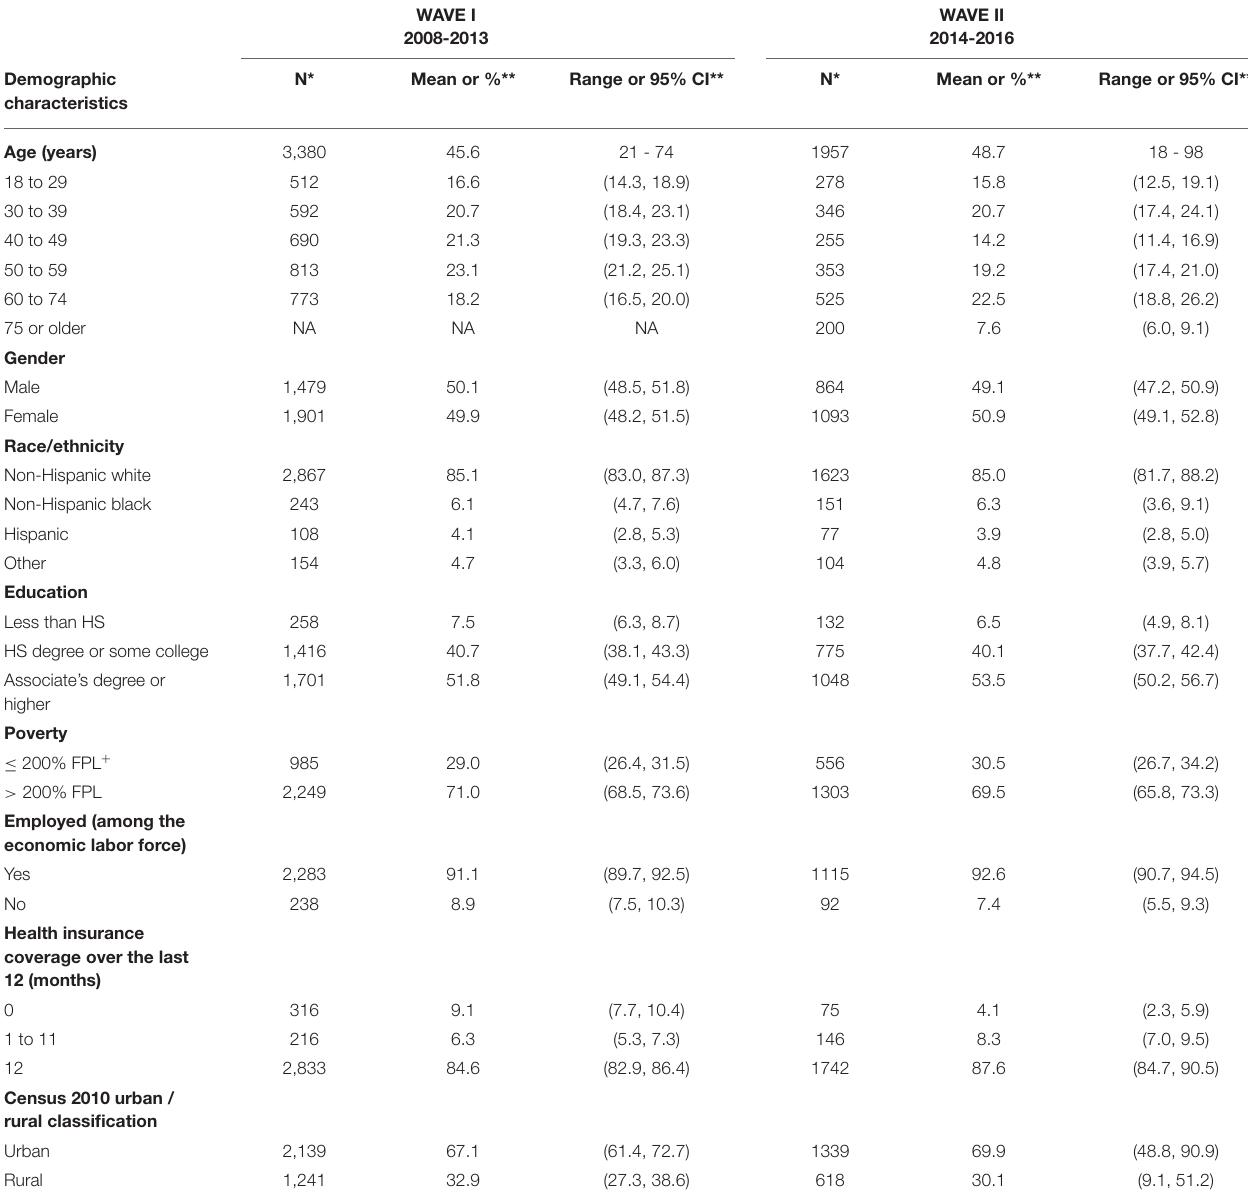
TABLE 2A | SHOW adults WAVES I and II characteristics, weighted for statewide sample